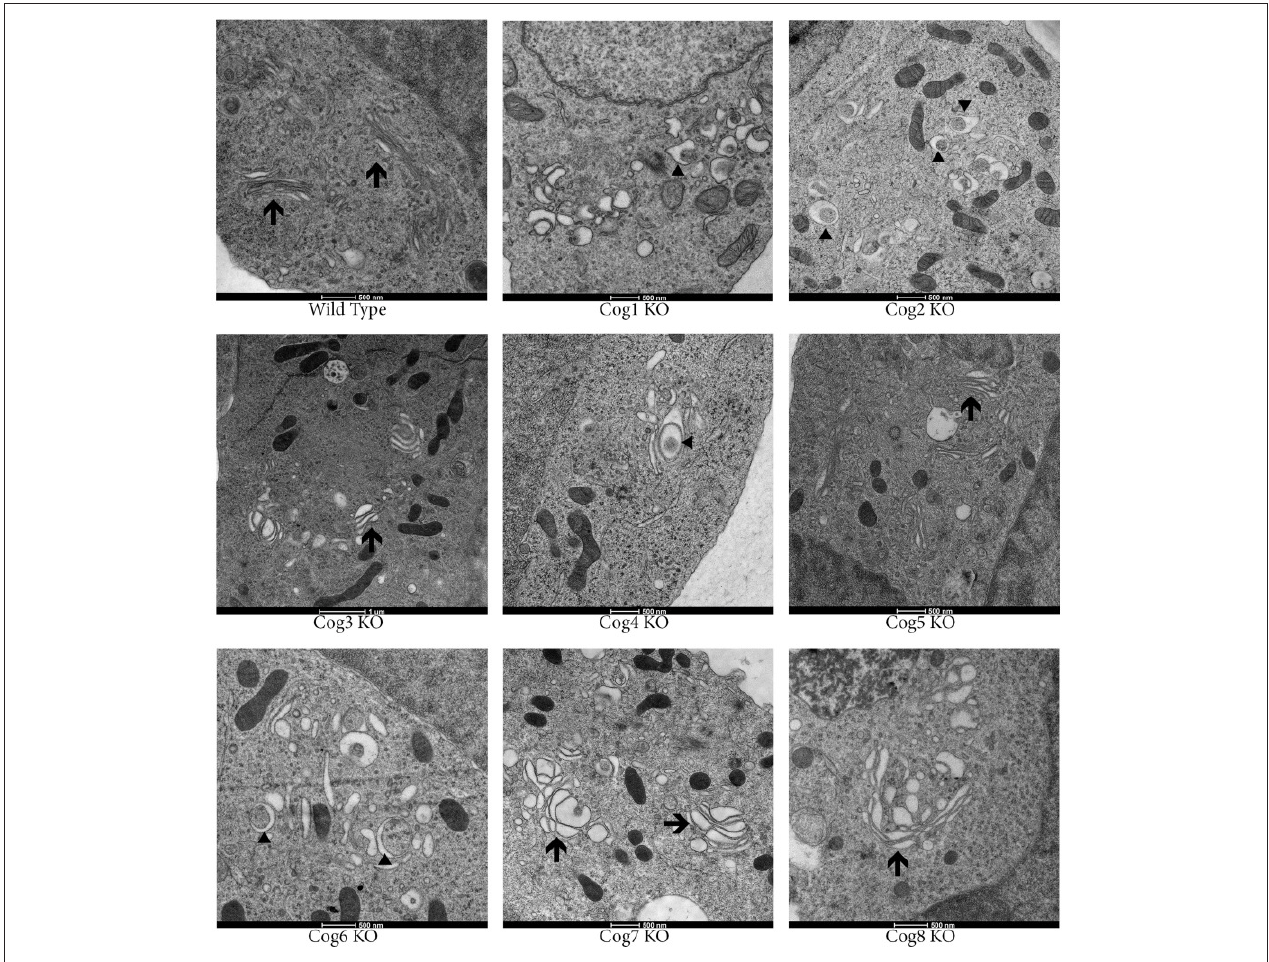
FIGURE 4 | Golgi structure is severely distorted in COG KO cells. Cells were grown on carbon and collagen coated sapphire disk then subjected to high pressure freezing and freeze substitution. Samples were stained with tannic acid and osmium before embedding then uranyl acetate and lead citrate staining post sectioning. Arrows indicate Golgi stacks. Arrowheads indicate autophagosomal like